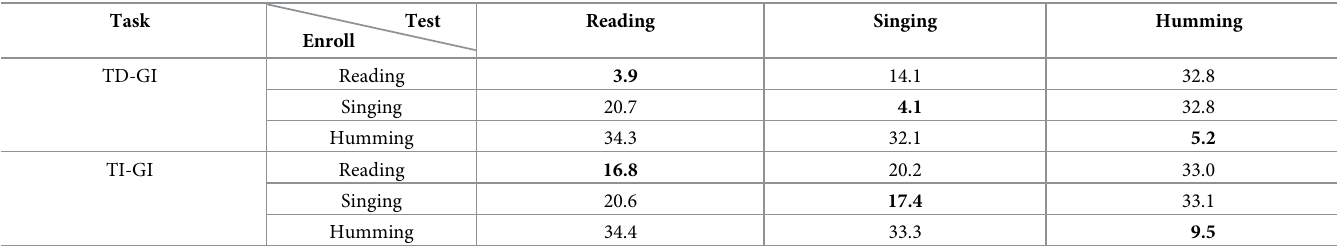
Table 6. EER% on the x-vector based cross-speaking ASV tasks.